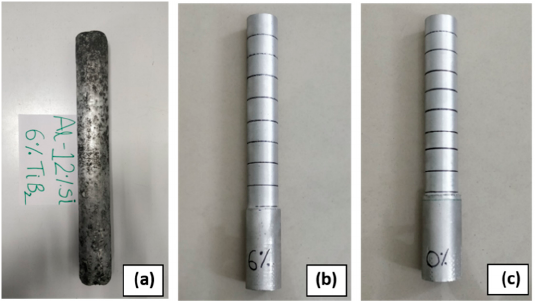
Figure 1. Machining specimens: ( a ) metal matrix composite (MMC), as casted; ( b ) MMC, after machining; ( c ) Base alloy, after